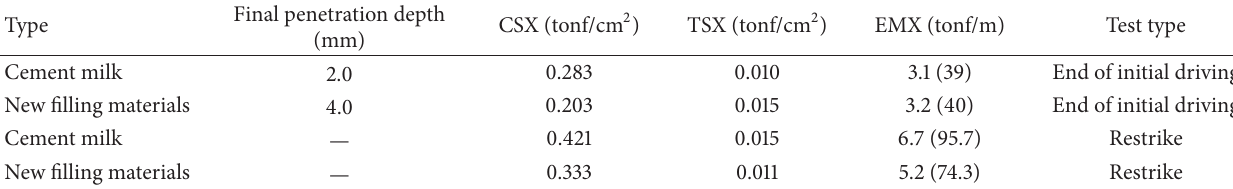
Table 5: Driveability analysis result of the dynamic pile loading test.